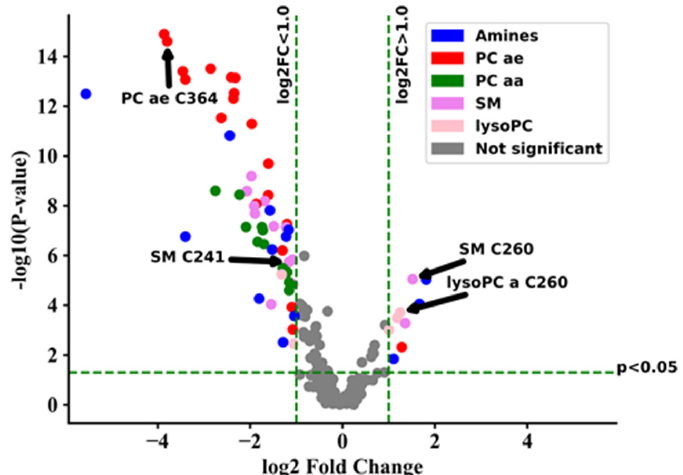
Figure 1. Volcano-plot showing metabolic changes of Zellweger syndrome spectrum patients (ZSS/ PEX1 ) in serum compared to control group. Components with a raw p -value < 0.05 and log2 fold change (log2FC) > 1.0 are displayed in color. lysoPC: lysophosphatidylcholine; PC aa: phosphatidylcholines with two acyl-linkages; PC ae: phosphatidylcholine with one acyl and one ether linkage; SM: sphingomyelin.